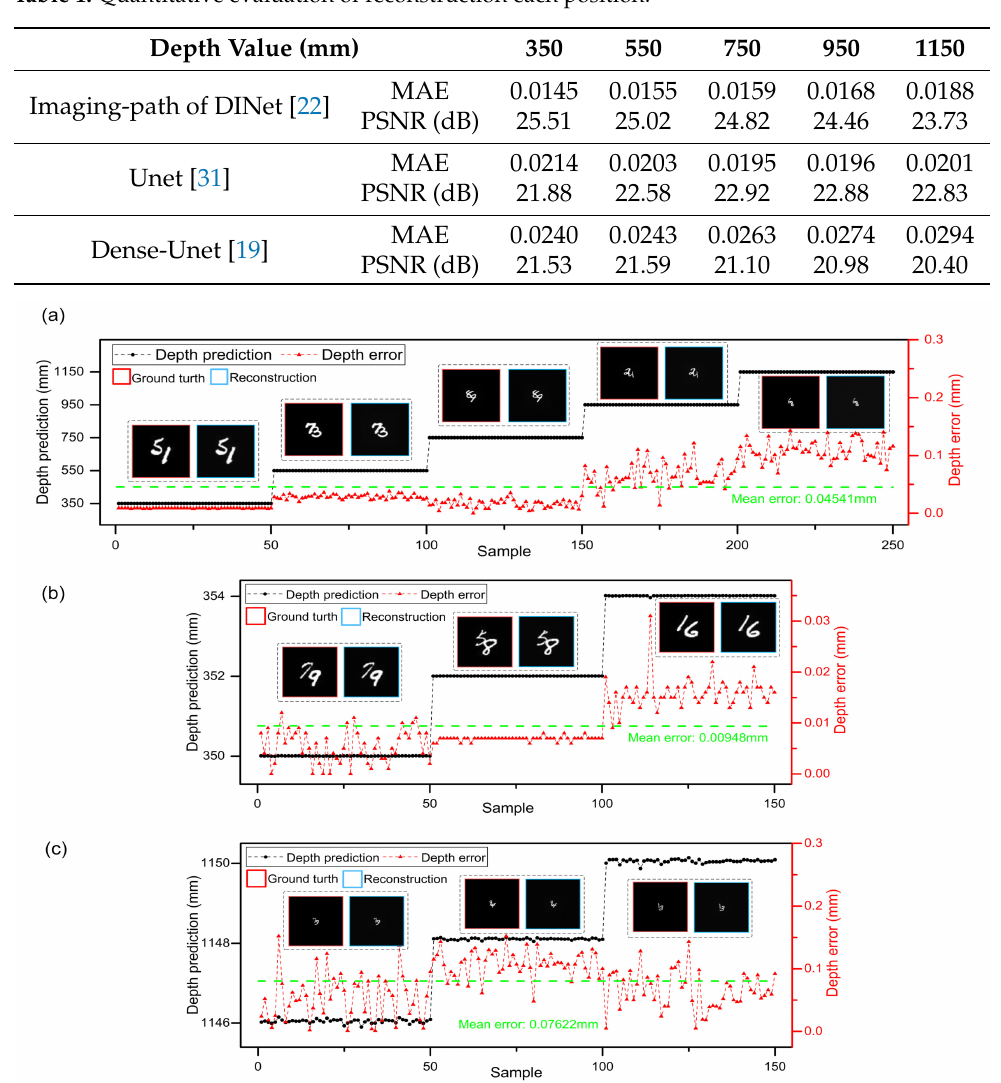
Figure 3. Quantitative evaluation for the DINet. ( a ) The depth predictions and errors in 5 positions. An object ground truth and corresponding reconstruction are shown in each sample range. ( b , c ) are the resolution capability of the DINet in different